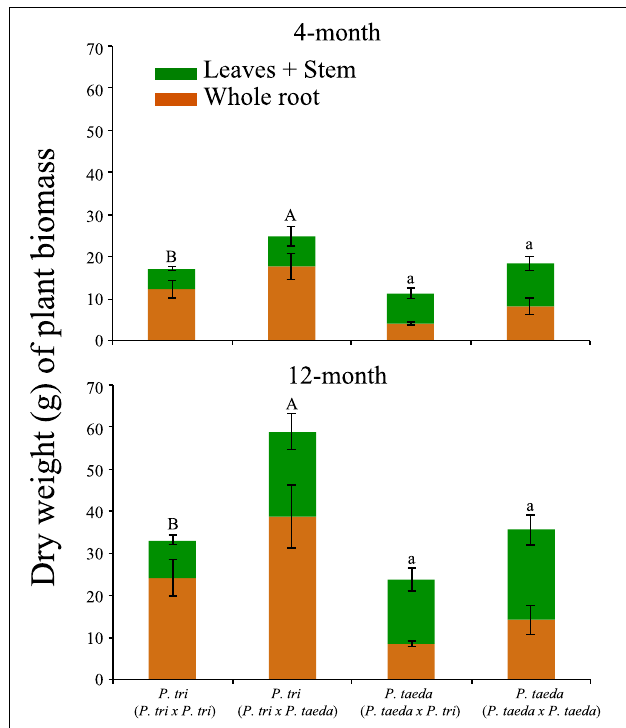
FIGURE 2 | Plant biomass (dry weight and standard deviation) of aboveground plant (above) and root tissue biomass (below) for seedling grown under different plant combinations: Populus trichocarpa grown with P. trichocarpa ( P. trichocarpa × P. trichocarpa ), P. trichocarpa with Pinus taeda ( P. trichocarpa × P. taeda ), P. taeda with P. trichocarpa ( P. taeda × P. trichocarpa ) and P. taeda with P. taeda . Significant groupings determined by Tukey test for whole plant biomass for the individual plant species ( P < 0.05, n ≥ 4). Means are marked by the same letter were not significantly different (Uppercase for P. trichocarpa ; Lowercase for P. taeda ). P. tri = P. trichocarpa